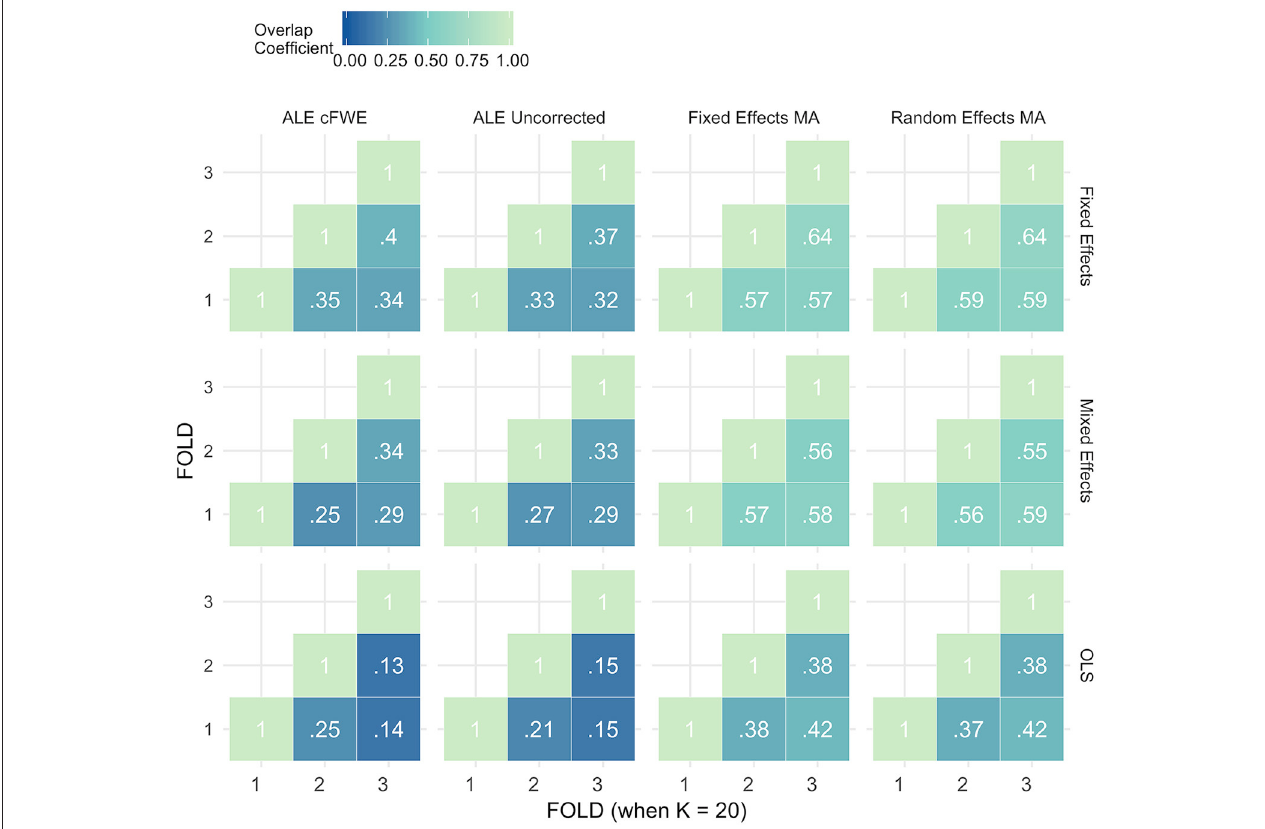
FIGURE 8 | Percent overlap of activation ( ω a , b ) from all pairwise comparisons for K mixed effects and OLS). The columns represent the thresholded meta-analyses. From left to right: ALE cFWE at 0.05, ALE uncorrected at 0.001 and fixed and random effects CBMA at 0.005 with Z >